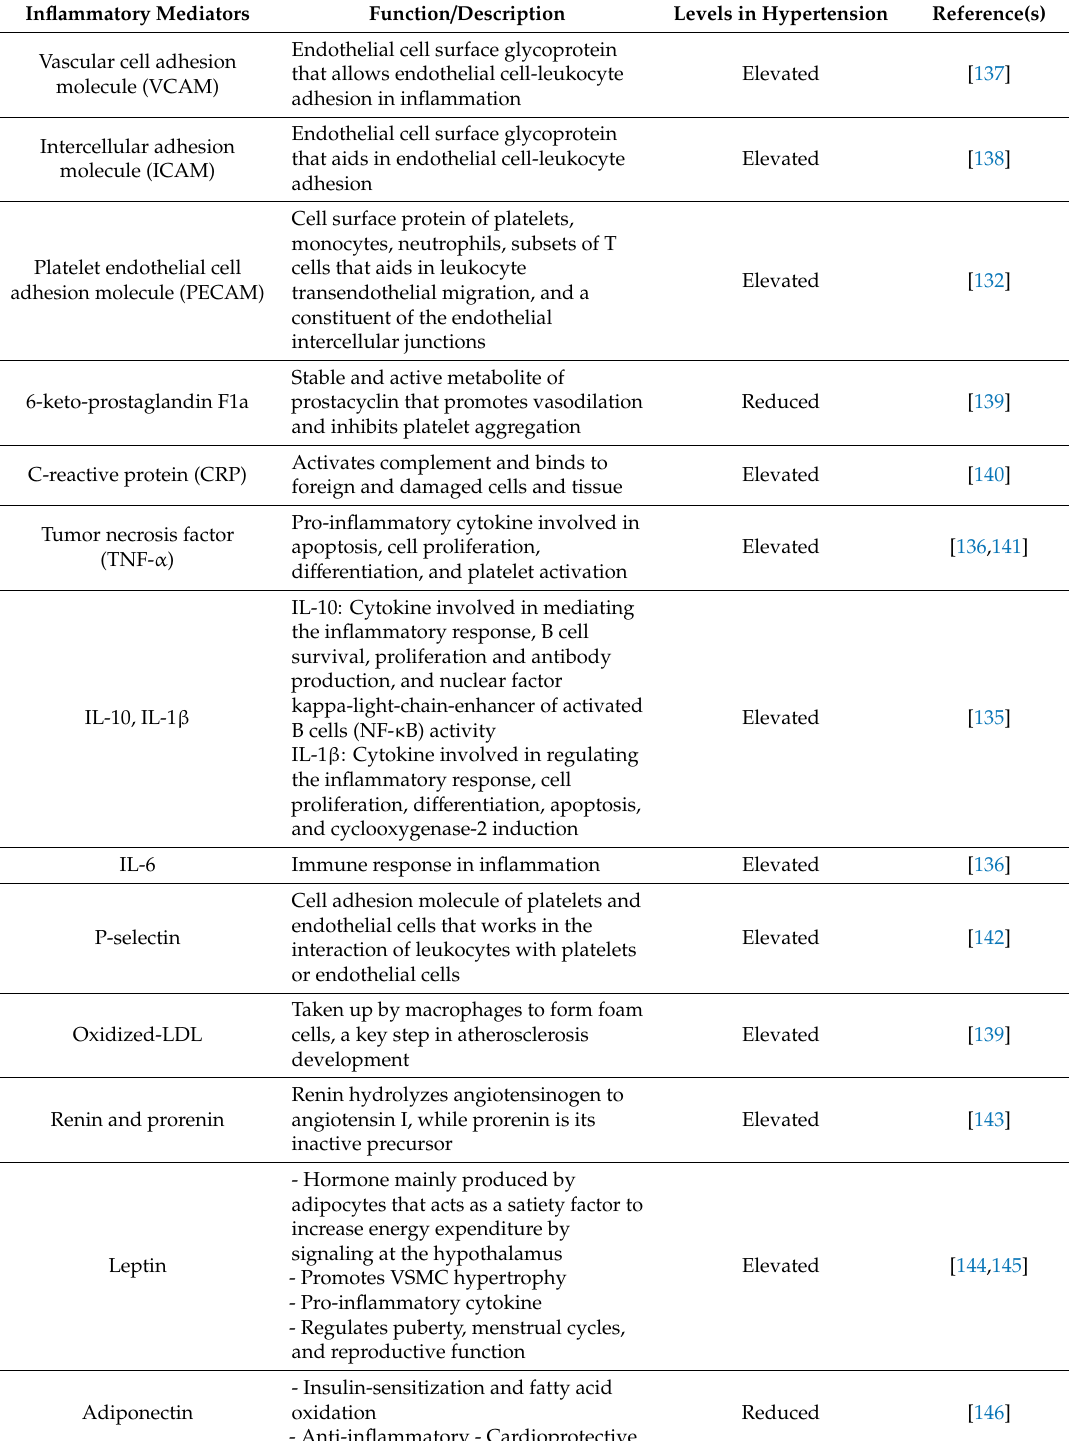
Table 5. Inflammatory biomarkers of